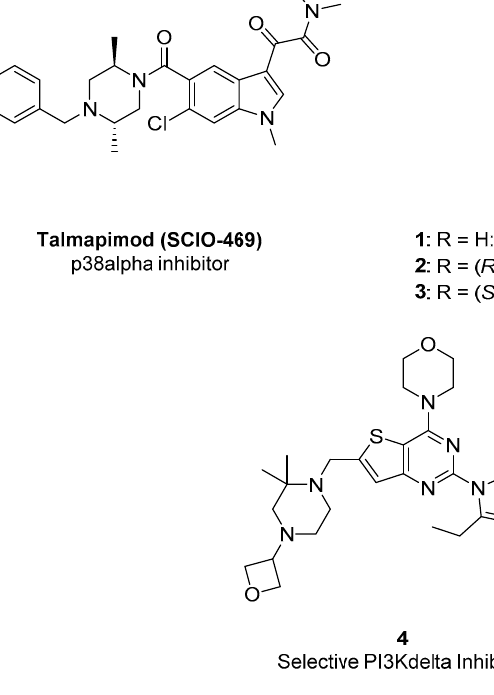
Figure 2. 3-Methylpiperazine-containing pre-clinical kinase inhibitors.